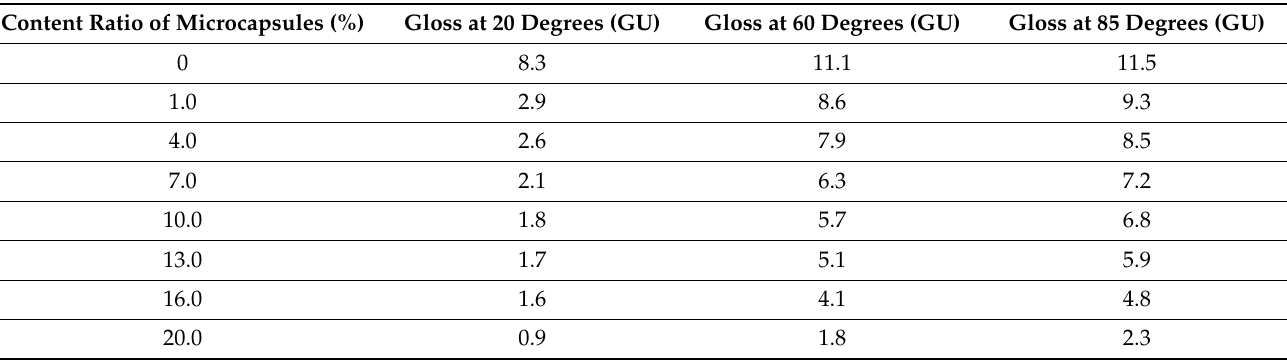
Table 4. Gloss performance table with core ratio of 0.83.